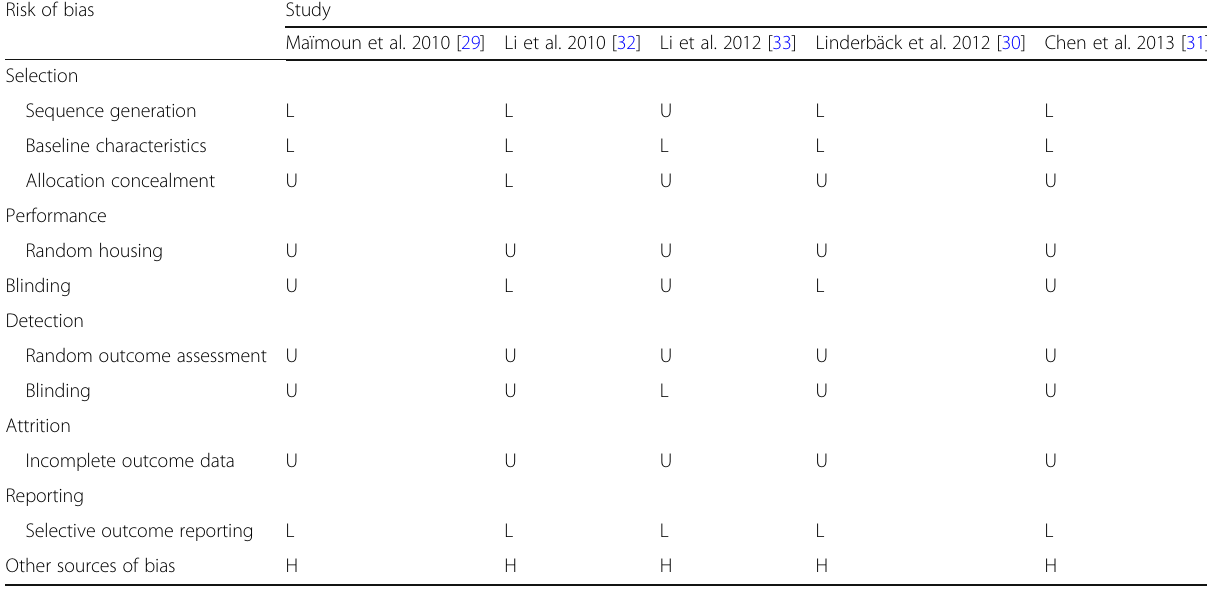
Table 3 Assessment of risk of bias using SYRCLE ’ s tool Risk of bias